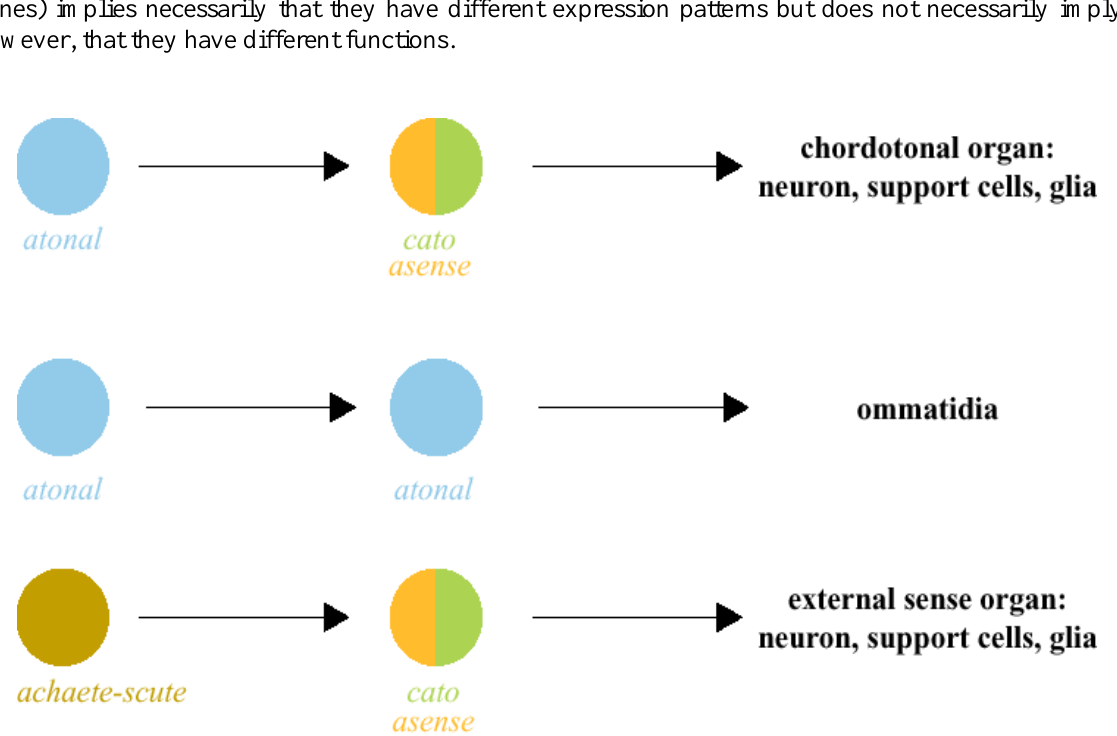
FIGURE 7. Proneural genes and sense organ specification in Drosophila. Sense organ precursors expressing atonal or achaete-scute genes are shown. Depending on where they do form, atonal-expressing precursors generate chordotonal organs (ch organs) or ommatidia. achaete-scute- expressing precursors generate external sense organs (es organs). Both es and ch organ precursors express neural precursors genes such as the bHLH genes cato and asense and generate the full set of cells constituting the sense organs, i.e., accessory cells, neurons and glia. The atonal- expressing cells in the eye become R8 photoreceptors that induced neighbouring cells to form the remaining 7 photoreceptors and several accessory cells constituting the